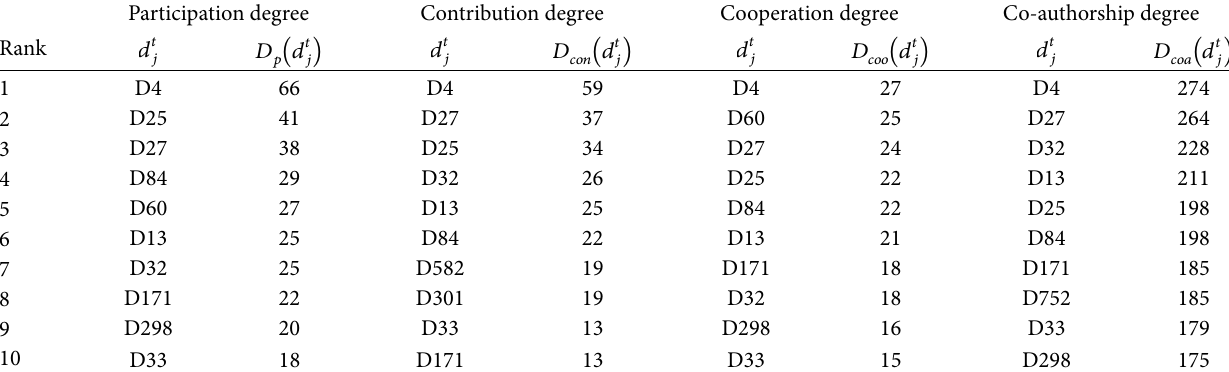
Figure 8: The standard networks of different mobile communication technology. (a) GSM, (b) CDMA, (c) WCDMA, (d) Table 6: The top ten drafters with high indicators in GSM system.